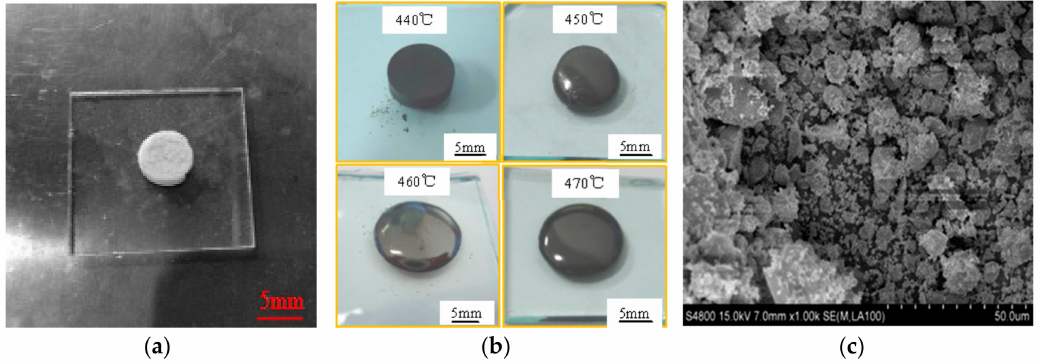
Figure 2. Experimental materials: ( a ) the glazing; ( b ) the solder shape at di ff erent temperatures; ( c ) microstructure of the sealing solder under scanning electron microscope (SEM).